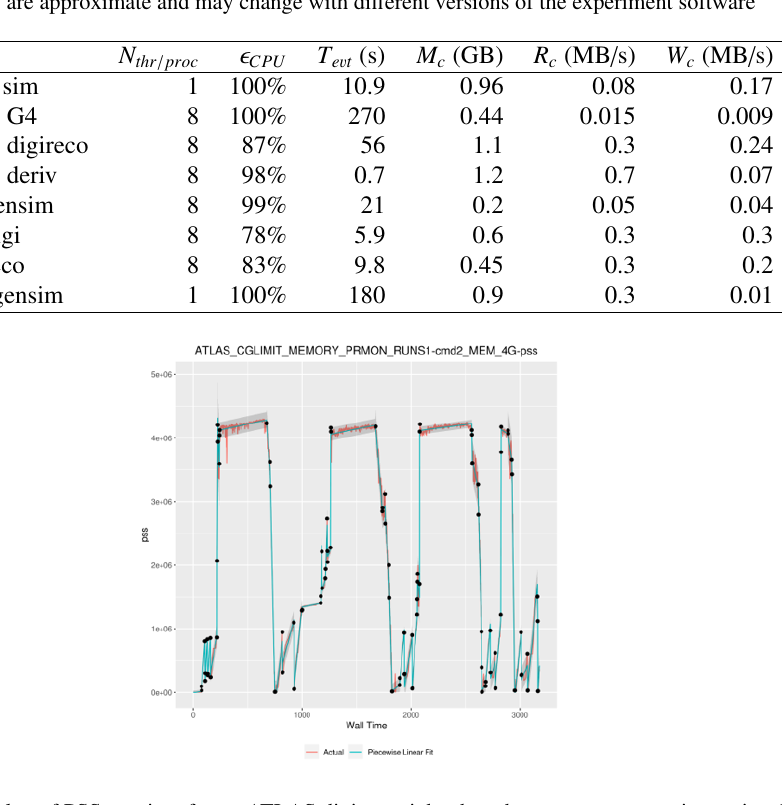
Figure 1. Value of PSS vs. time for an ATLAS digi-reco job when the system memory is restricted to 4